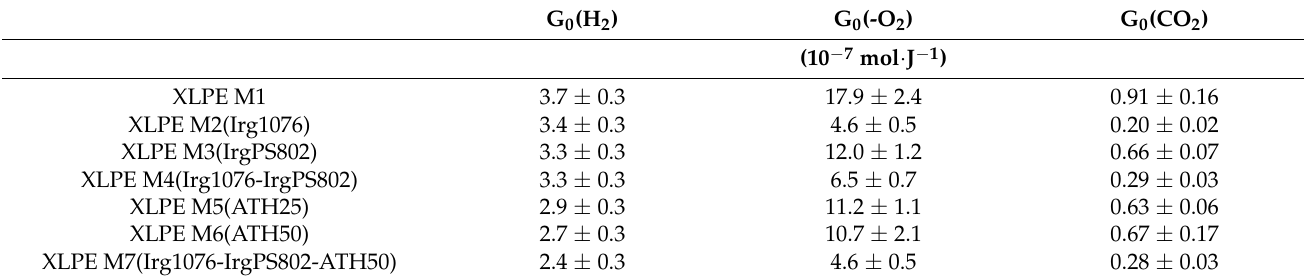
Table 1. Radiation chemical yields extrapolated at zero dose, obtained for the seven